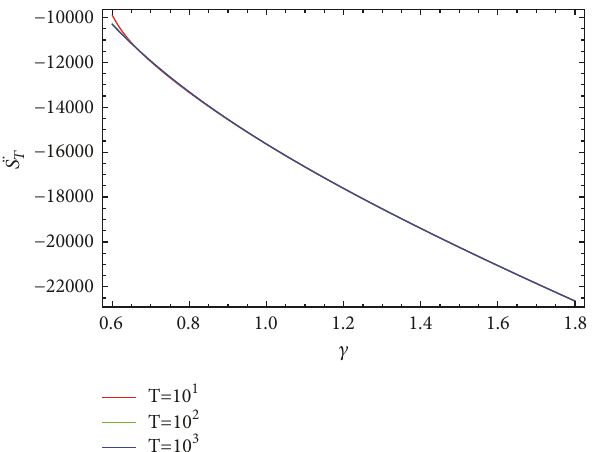
̈𝑆 𝛾 when logarithmic corrected entropy Γ = Γ(𝑡) Figure 10: Plot of 𝑇 versus